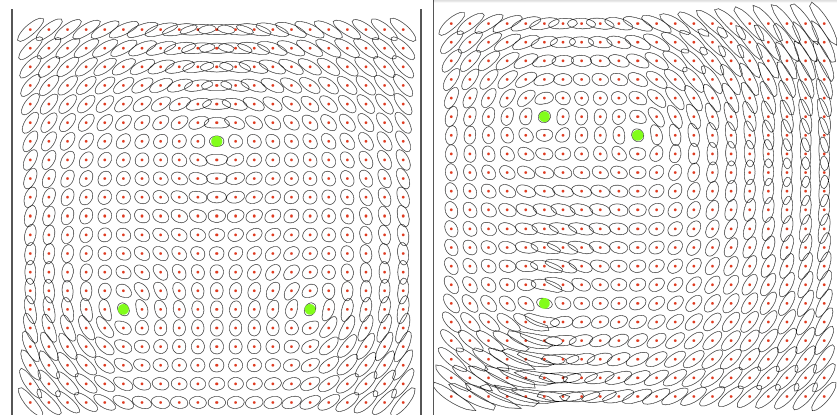
FigureA1. Qualityofpositiondeterminationnearthreeresponders(2-Dcase). Left: Symmetricarrangement. Right: Asymmetric